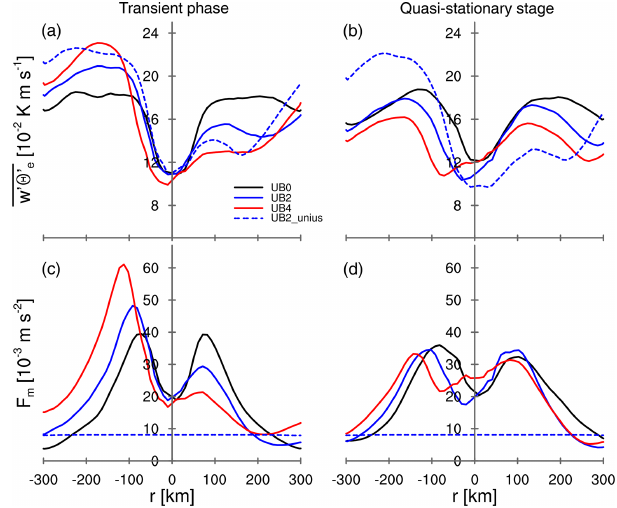
Figure 3. Radial distributions of the azimuthally averaged (a, b) w (cid:48) θ (cid:48) e and (c, d) F m . Quantities are averaged over 5d and 10km in r direction. The averaged quantities for (a, c) transient stage over day 0 to 4 and (b, d) quasi-stationary stage over 15 to 19 are illus- trated. The negative and positive values of r represent the upwind area and downwind area,